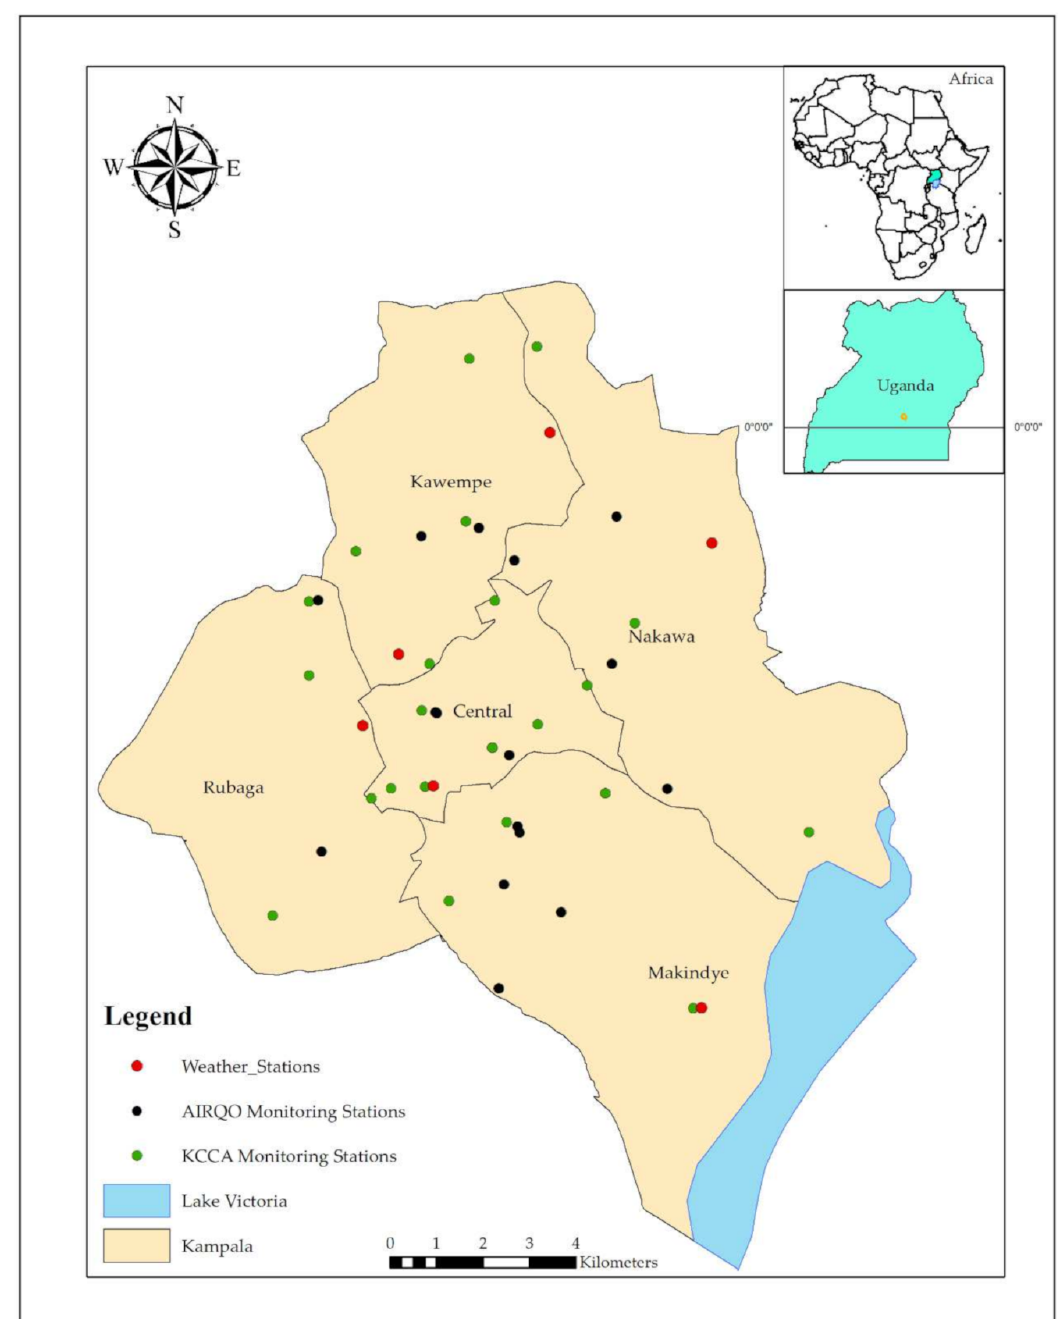
Figure 1. Distribution of PM 2.5 ground monitoring stations and weather stations within Kampala